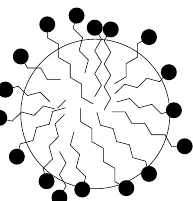
Figure 12. Possible location of the polar “heads” in a direct micelle from the SDS molecules and the POBM/SDS aggregate.